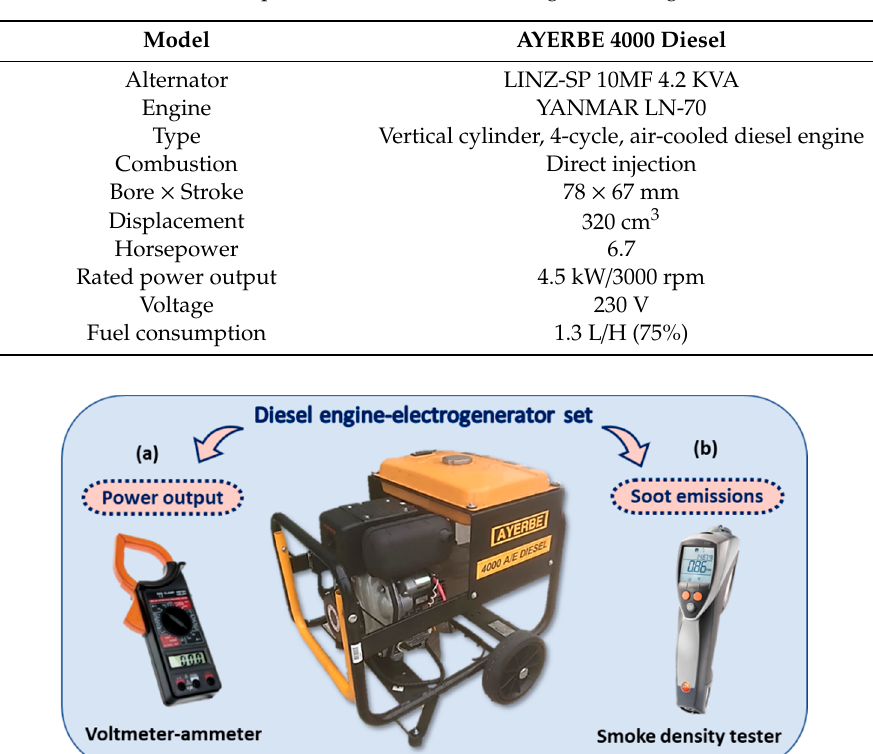
Table 2. Technical specifications of the Diesel Engine-Electrogenerator Set.